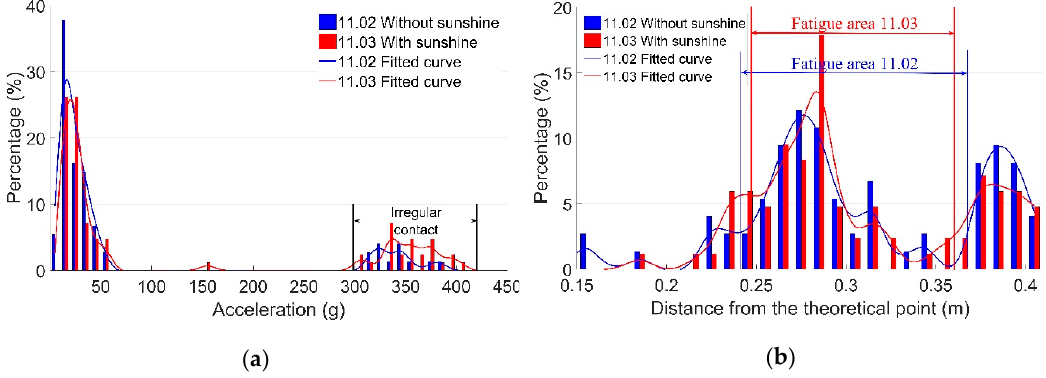
Figure 16. Influence of sunshine on the dynamic responses. ( a ) Vertical acceleration distribution; ( b ) fatigue area analysis.